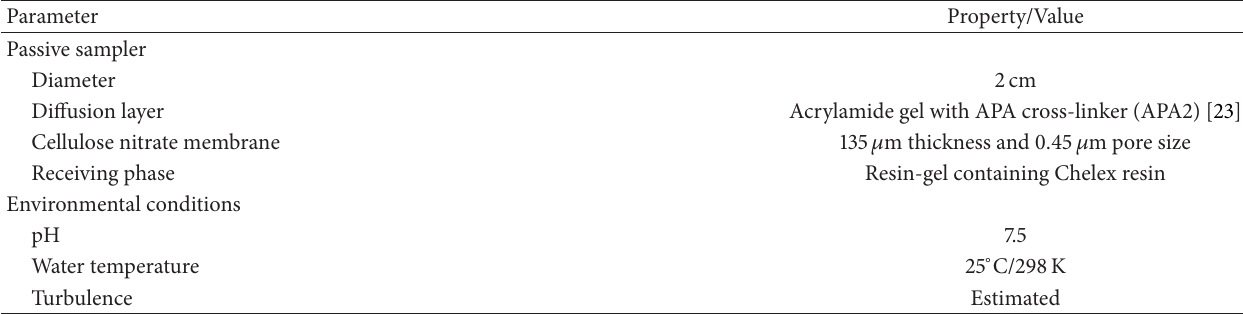
Table 1: Predefined passive sampler characteristics and environmental conditions used as a basis in the uncertainty calculations.